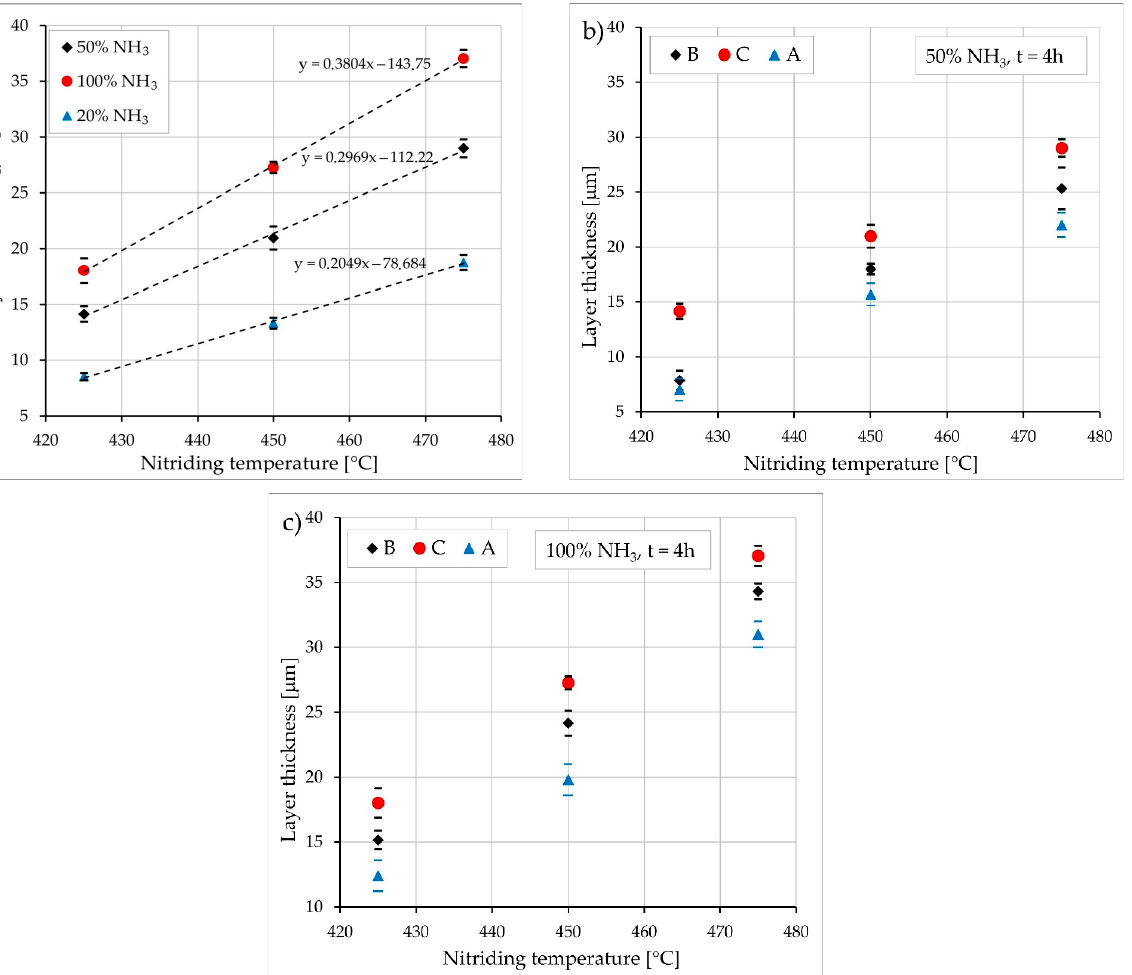
Figure 2. Thickness of nitrided layers in the function of nitriding temperature: ( a )—Nanoflex steel under condition C; ( b ) and ( c )—Nanoflex steel under conditions A, B and C. Light-microscopy photographs of microstructures of the nitrided layers are shown in Figure 3. The thickness of all layers was uniform on the entire surface of the samples, regardless of the nitriding conditions. The layers produced under different technological parameters demonstrated distinct susceptibilities to chemical etching. The layers obtained at the lowest temperature and with the least amount of ammonia in the atmosphere were white and much more resistant to etching with Mi19Fe etchant in comparison to layers nitrided at 450 and 475 °C or compared to layers nitrided in 50% and 100% ammonia at- mospheres. As the nitriding temperature increased, the dark area in the layer structure grew. This temperature effect is more pronounced for a higher nitriding potential (atmos- pheres with ammonia amount of 50 and 100%). The dark areas in the layer microstructure may suggest the presence of nitrides that change (deteriorate) the corrosive properties of the steel [7,36]. All layers contained a nitride sublayer close to the surface. The sublayer was visible in the scanning electron microscope photographs (Figure 4) of the cross-sec- tions of the layers, except for the layer obtained at 425 °C in an atmosphere of 20% ammo- nia. The described microstructure differs significantly from the needle-like microstructure observed by the authors in the case of nitrided layers on Nanoflex steel under condition A [27,43]. In the case of nitrided layers at 450 and 475 °C in an atmosphere of 100%